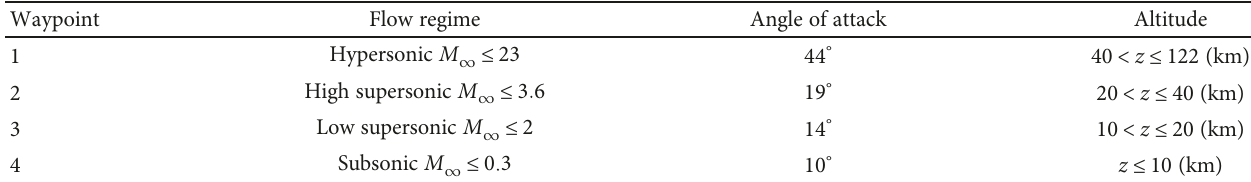
Table 2: Waypoints adopted for aerodynamic computation.